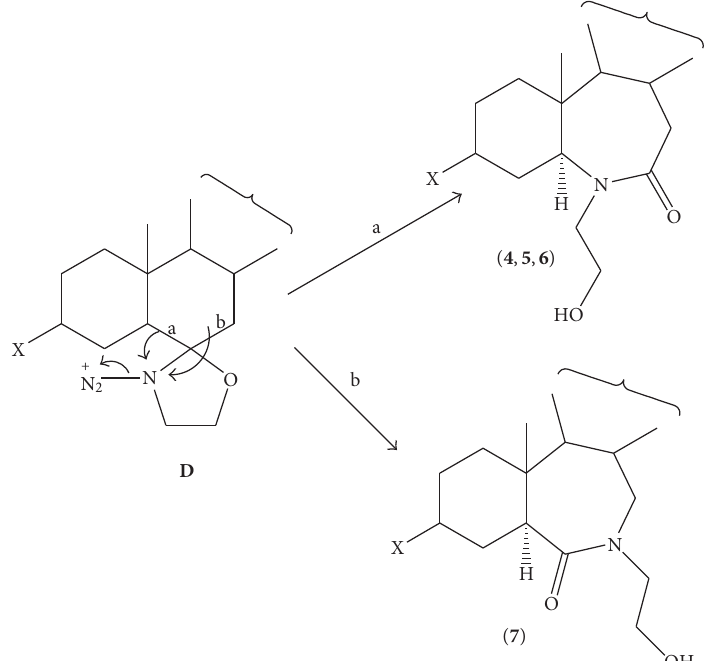
OH S 3: Migration ability of a and b carbon. T 2: Cytotoxicity of compounds 4 – 6 against the cell lines. Cytotoxicity of Cell lines